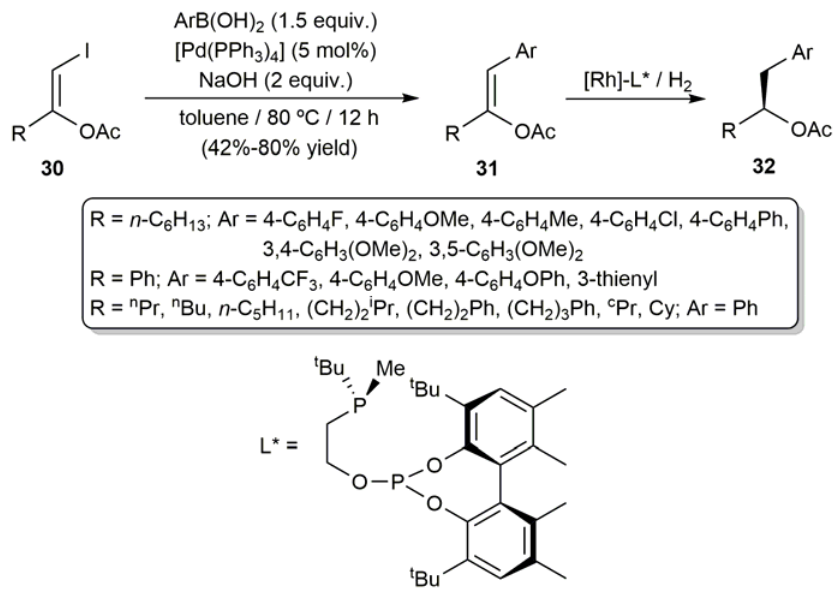
Scheme 18. Stereoselective synthesis of conjugated dienyl esters through Suzuki–Miyaura-type cross-coupling